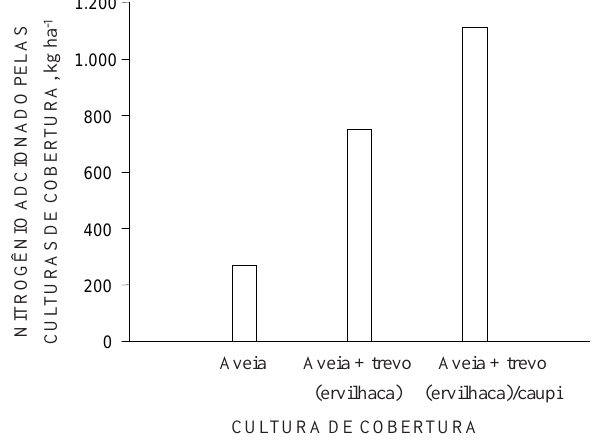
Figura 1. Estimativa do nitrogênio adicionado e, ou, reciclado pelas culturas de cobertura utilizadas em sistemas de rotação de cultura durante nove